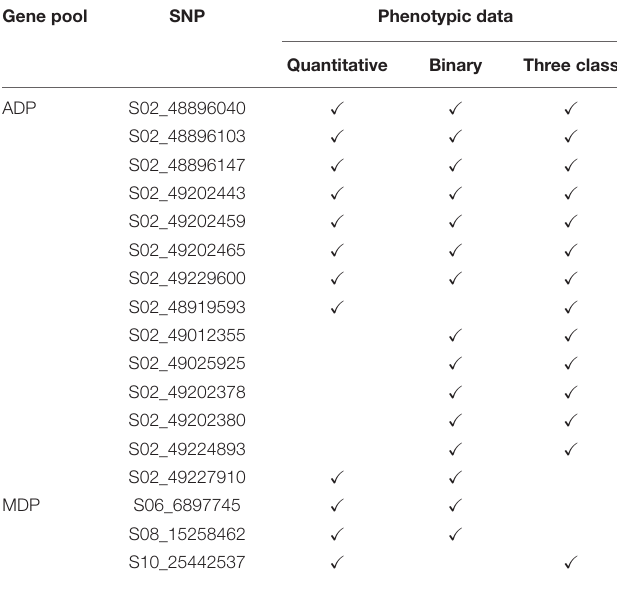
TABLE 6 | Shared significant SNPs from GWAS results for three scoring system in MDP and ADP gene pool. Gene pool